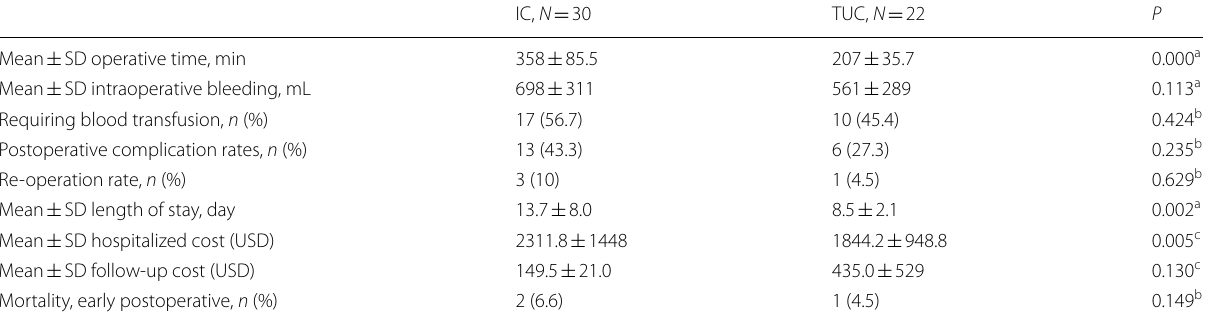
IC ileal conduit, TUC transuretero-cutaneostomy, SD standard deviation, USD United States Dollar a Using independent t test analysis b Using Chi-squared test analysis